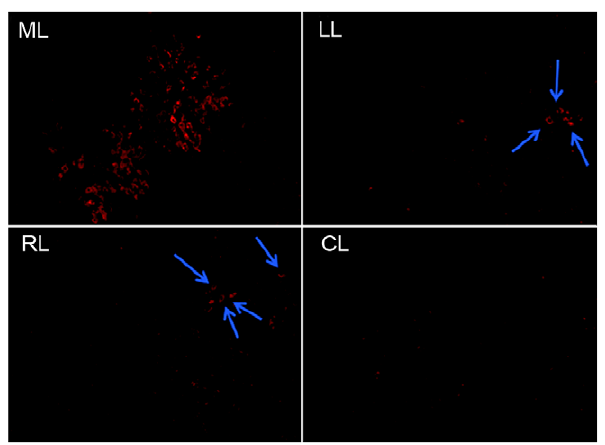
Figure 4. Immunofluorescent staining for ugt1a1 in different liver lobes. Three months after hepatocyte transplantation following HIR to median lobe (ML), 20% of the irradiated median lobe was replaced by donor hepatocytes, whereas the unirradiated left (LL), right (RL) and caudate (CL) lobes contained only small ugt1a1 + hepatocyte clusters.